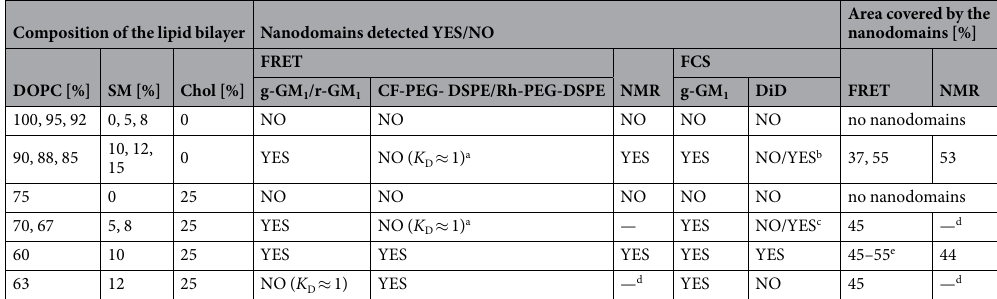
Table 3. Nanodomains as detected by FRET and two different D/A pairs, solid-state NMR and z-scan FCS. a This D-A pair is equally distributed between the nanodomains and the remaining bilayer and thus the existence of the nanodomains does not have an effect on the FRET phenomenon; b the decrease in D, which indicates the presence of nanodomains, was only significant (p < 0.1) for the bilayers composed of 15% SM; c only for 8% SM; d not determined; e 45% with GM 1 pair, 55% with DSPE